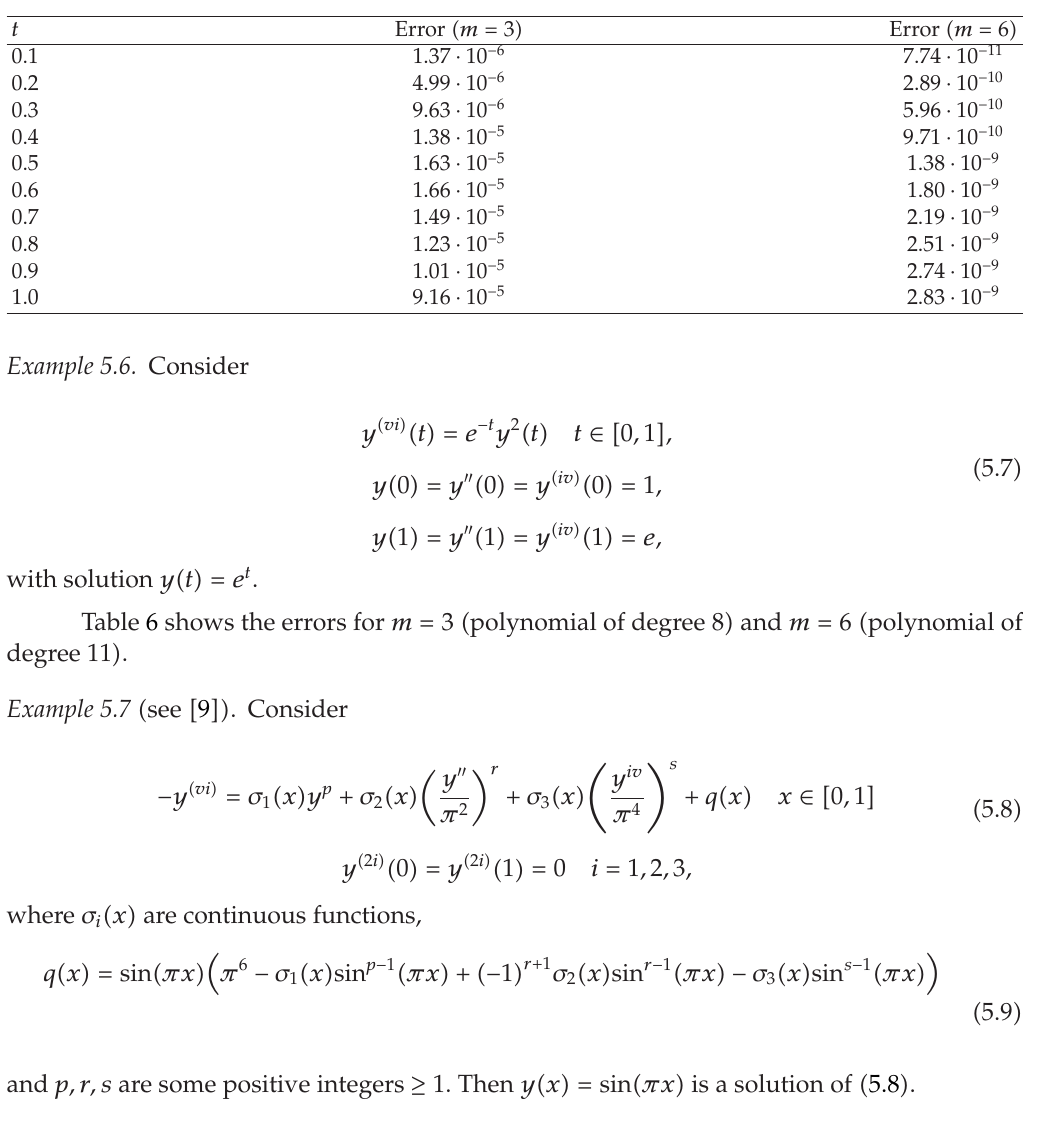
Table 5: Problem (cid:4) 5.6 (cid:5) —Example